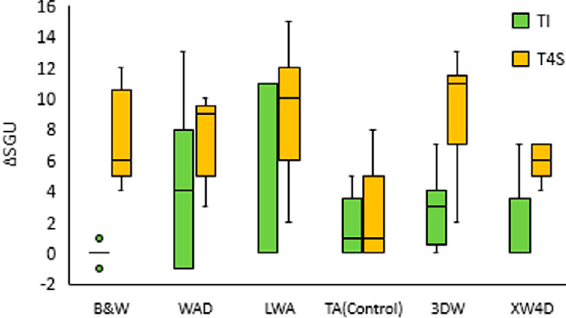
Figure 3- Whitening efficacy values expressed by the difference in shades units (ΔSGU) between the baseline (T0) and after first use (TI) and after 4 weeks of use (T4S) for each